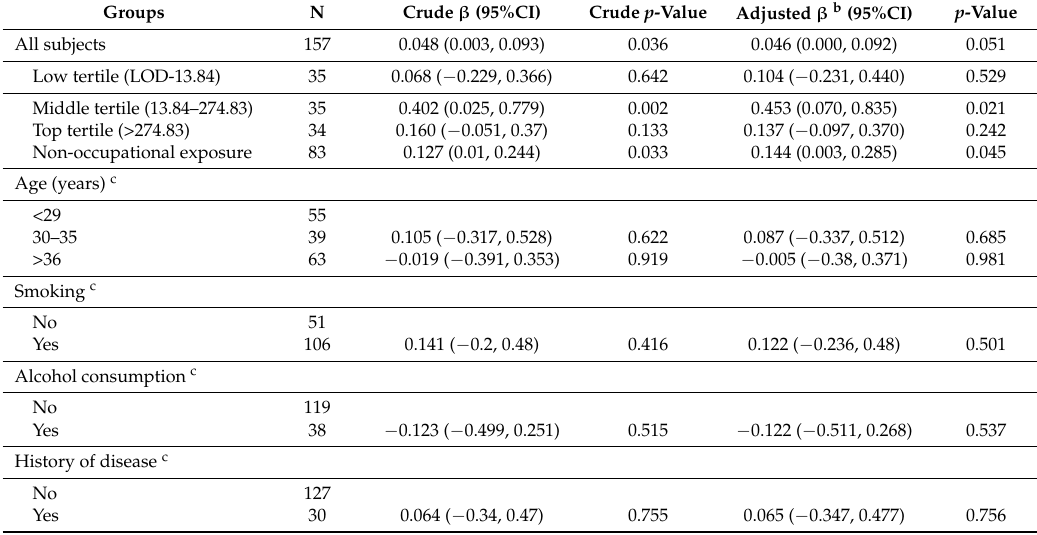
Table 4. Linear regression of BPA exposure and the 5hmC rate of the sperm ACHE gene a